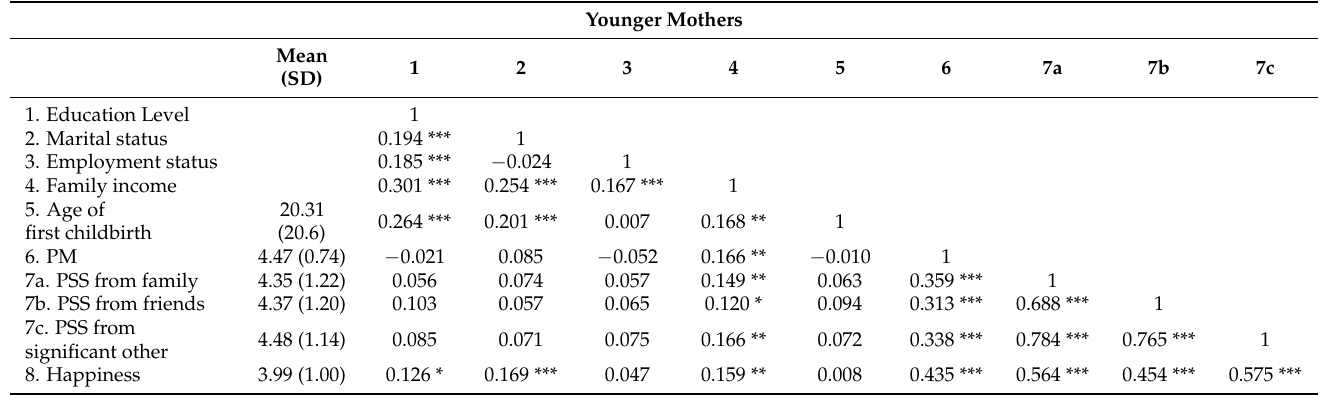
Table 4. Summary of means, standard deviations, and zero-order correlations among the demo- graphic control variables, presence of meaning in motherhood (PM), perceived social support (PSS), and happiness among younger mothers ( n = 361).